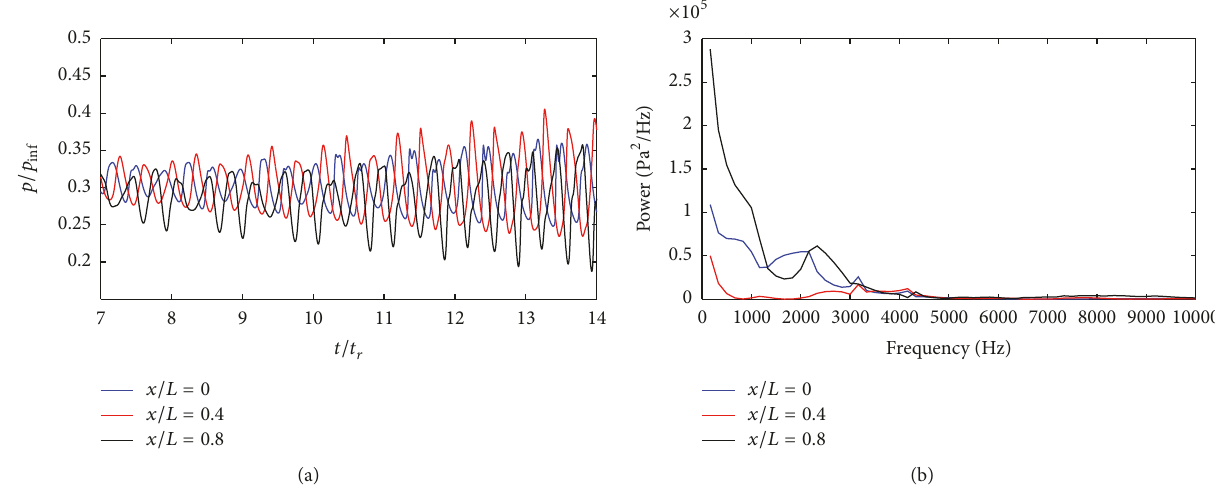
Figure 13: The results for cavity floor ( 𝑥/𝐿 = 0 , 0.4, and 0.8). (a) Pressure distribution. (b) Power spectrum (CP4).